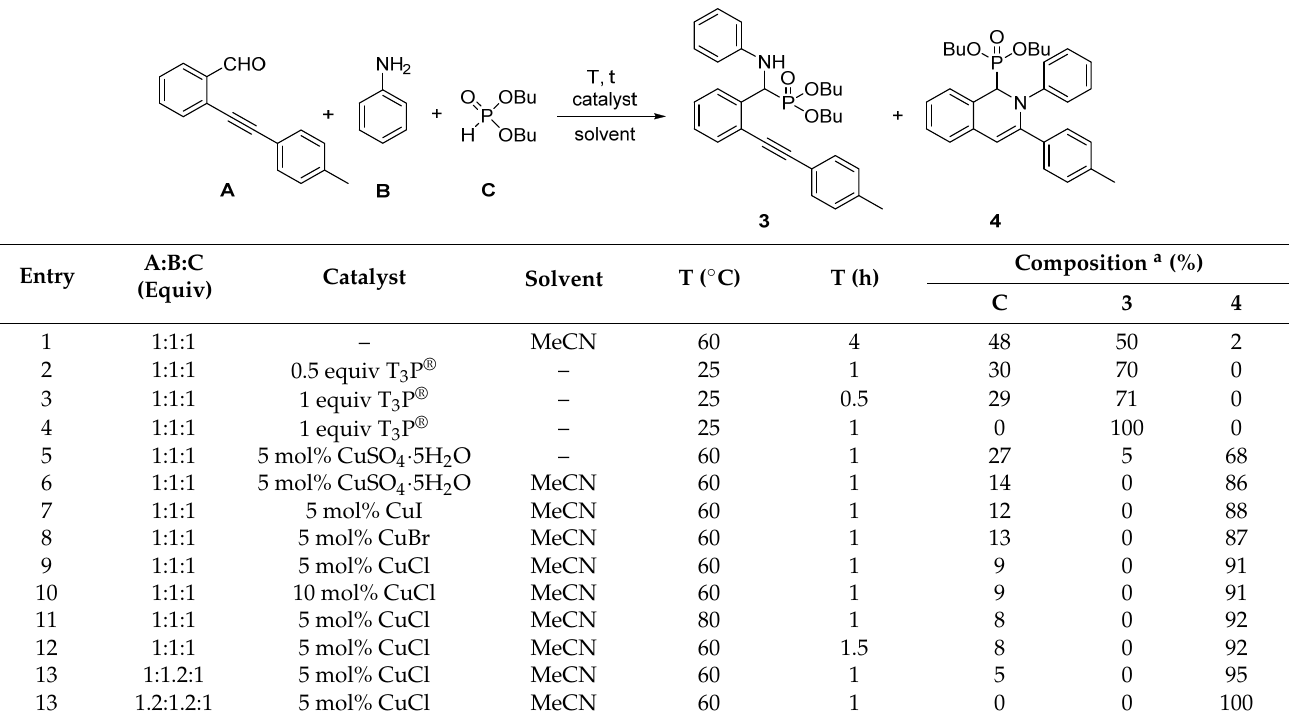
Table 1. Investigation of the condensation of 2-( p -tolylethynyl)benzaldehyde, aniline, and dibutyl phosphite.